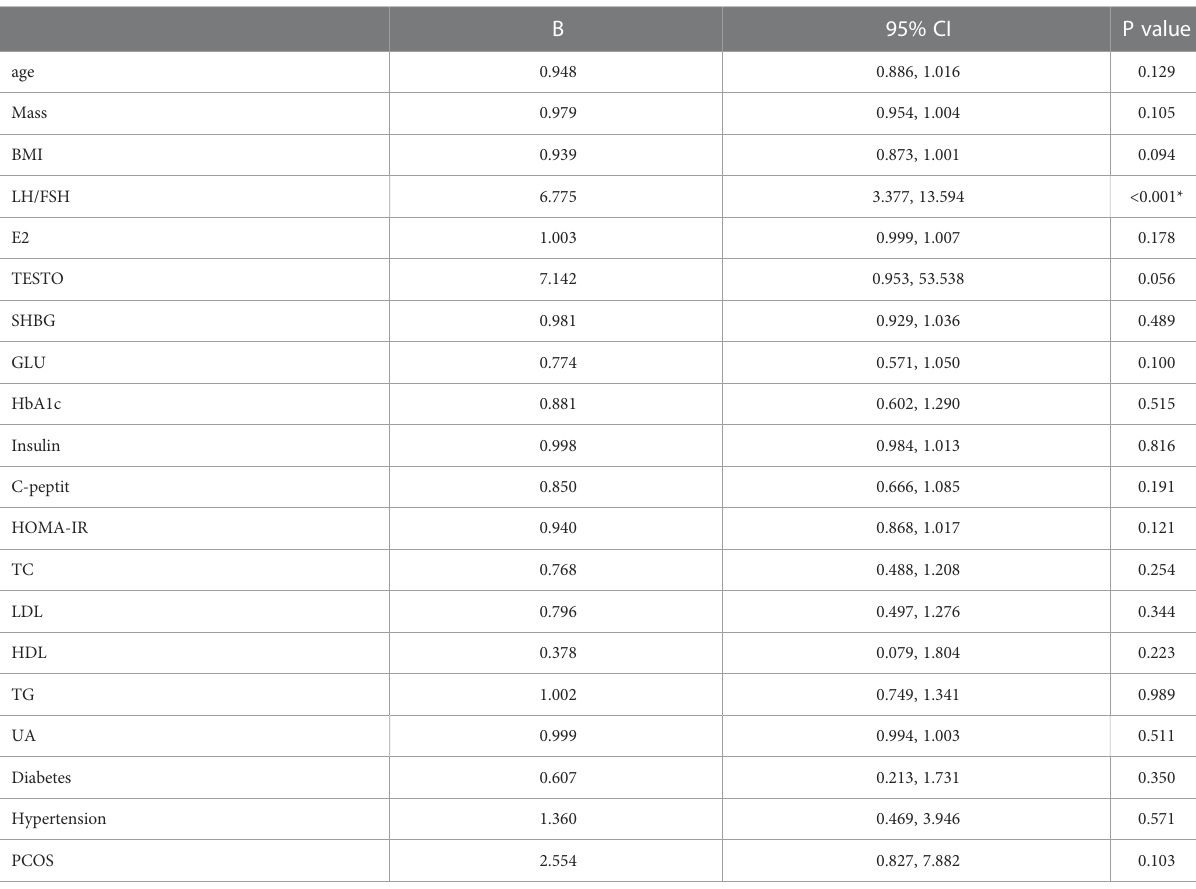
TABLE 4 Prognostic factors for recovery of OA at 12 months postoperatively.